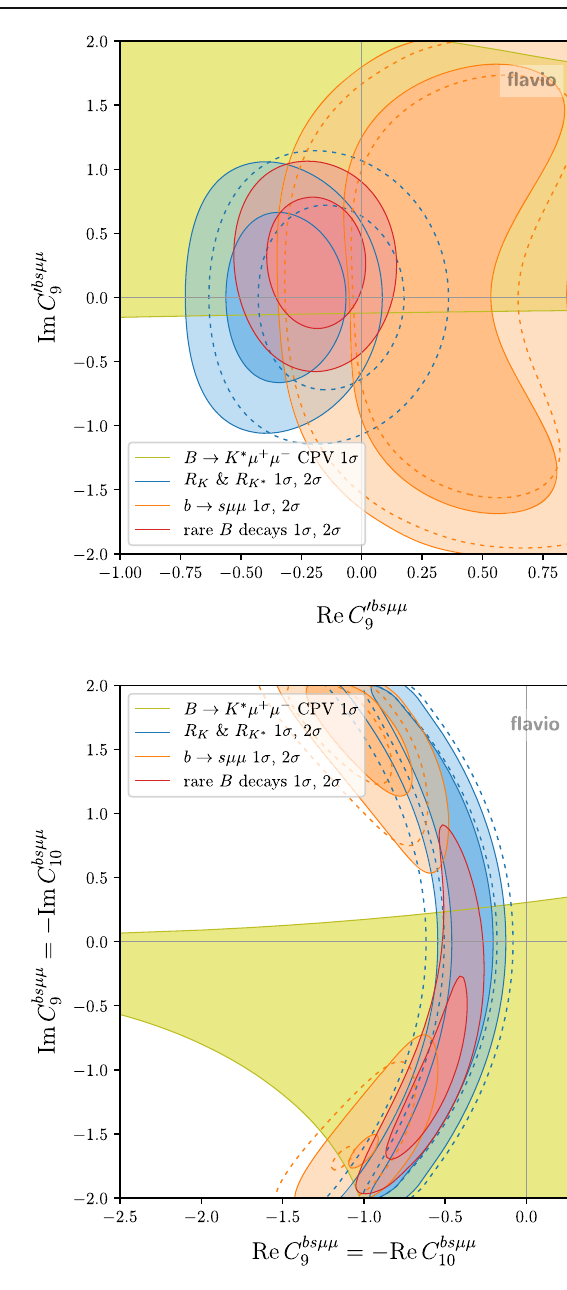
Fig. 7 Constraints in the planes of complex C bs μμ (top right), C bs (bottom left), and C bs 10 Shown separately are the constraints from LFU observables, CP con-